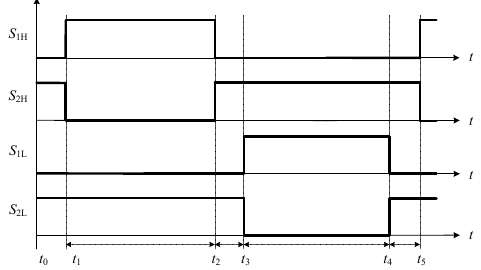
Figure 6. Logic signals of S 1H , S 2H , S 1L and S 2L in the proposed driver. Mode 1 [ t 1 ~ t 2 ]: S 1H is turned ON, S 2H is turned OFF. S 1L is still OFF-state and S 2L is still